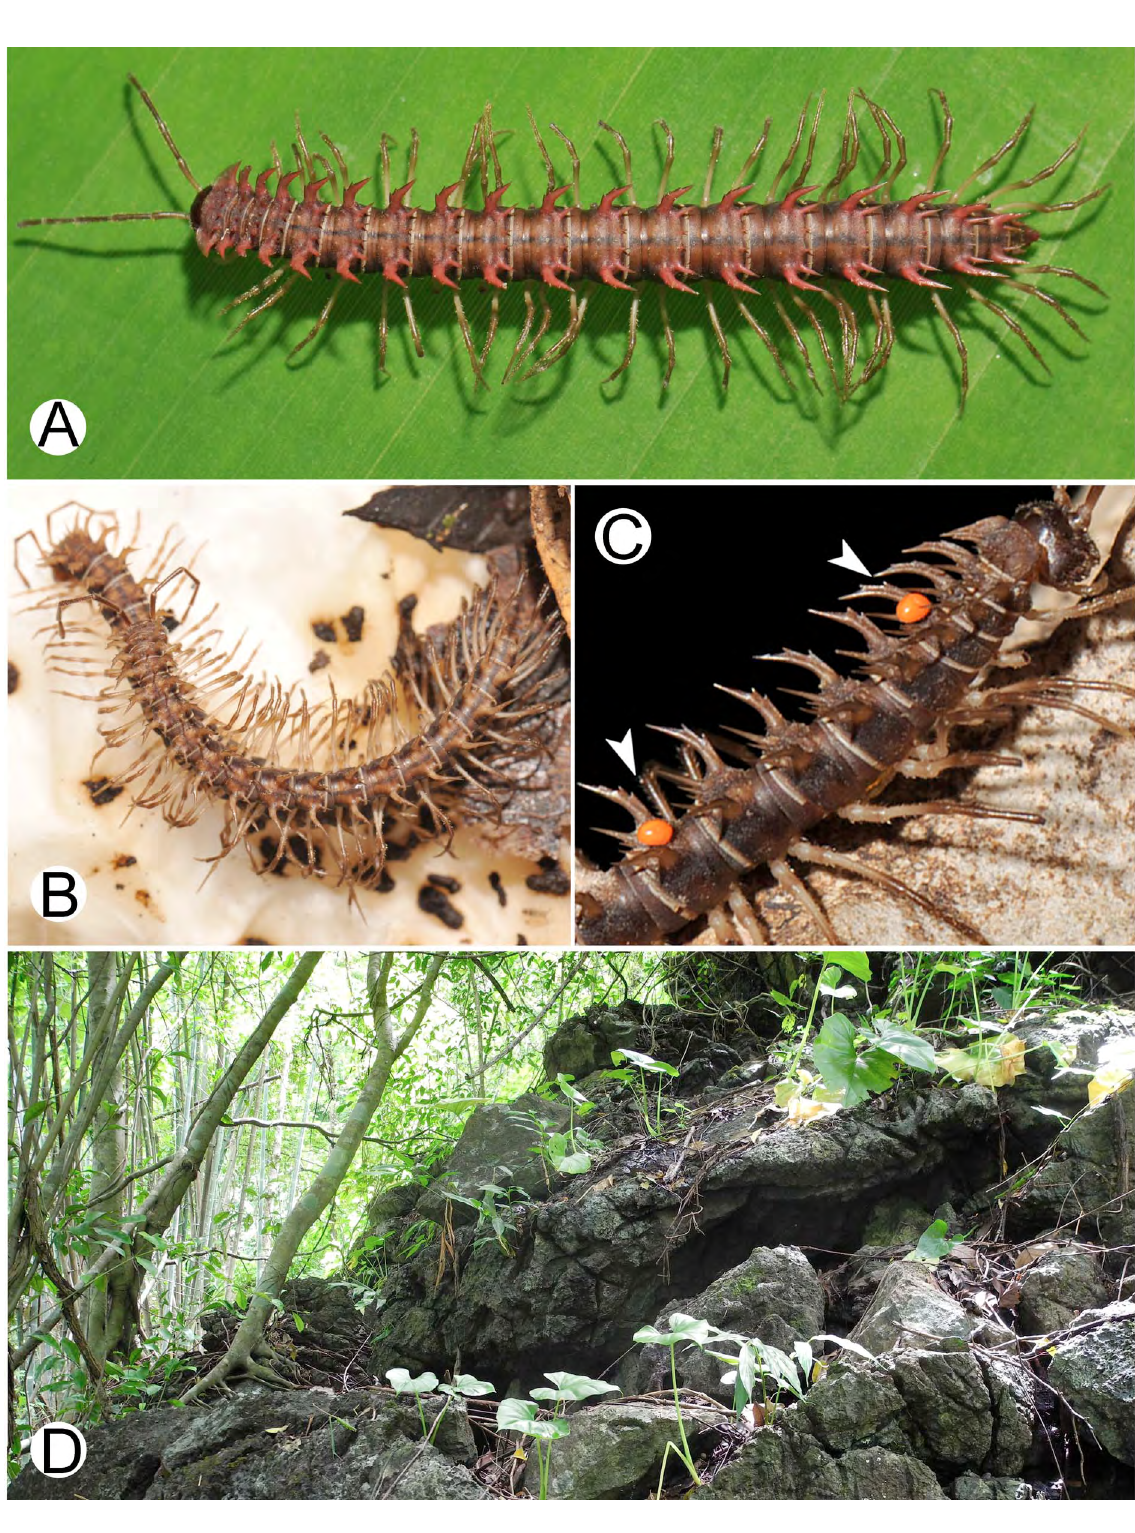
Fig. 12. Live photographs and habitat of Nagaxytes erecta Srisonchai, Enghoff & Panha gen. et sp. nov. A . Specimen from Ban Nong Bang, Thailand (♀). B . Mating couple. C . ♂ with parasitic mites. D .